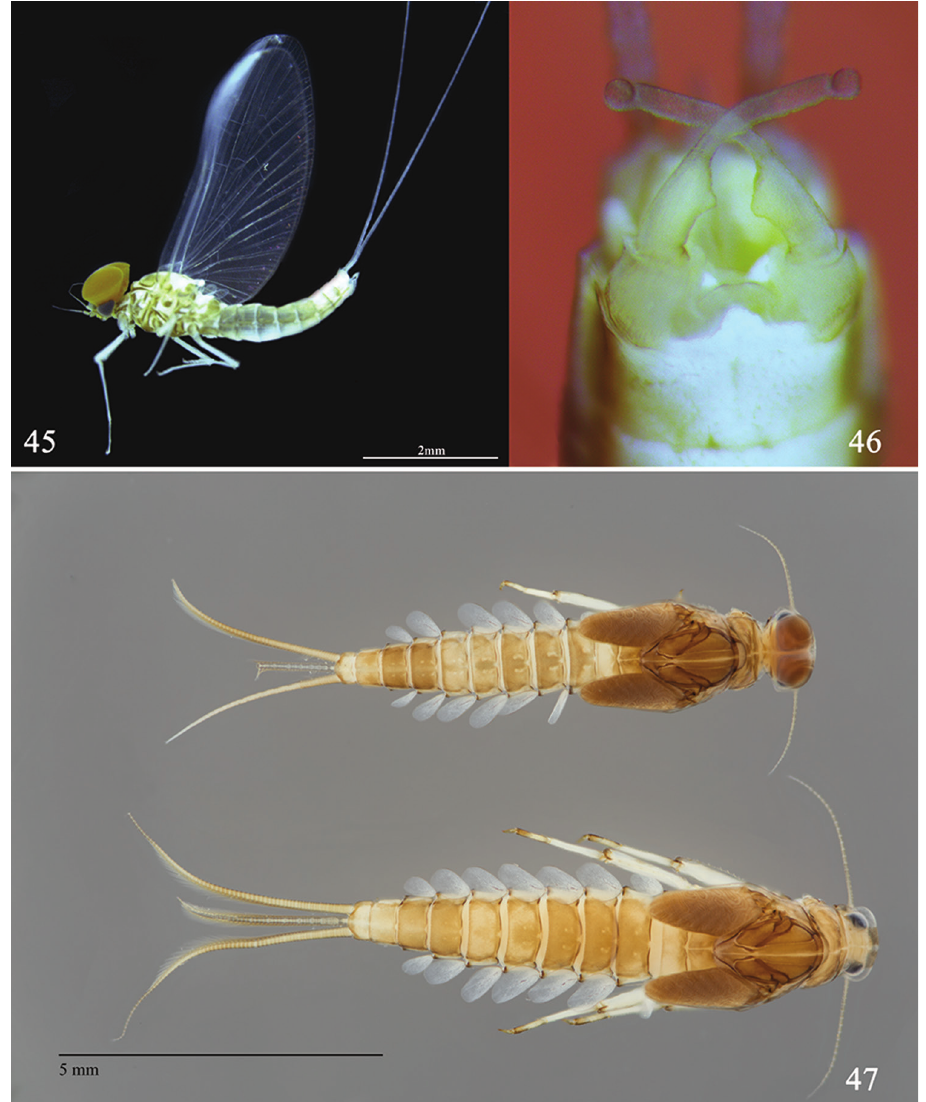
Figures 45–47. Larval and imaginal structures of Labiobaetis glaucus : 45 male imago (lateral view) 46 male genitalia 47 male and female larvae (dorsal